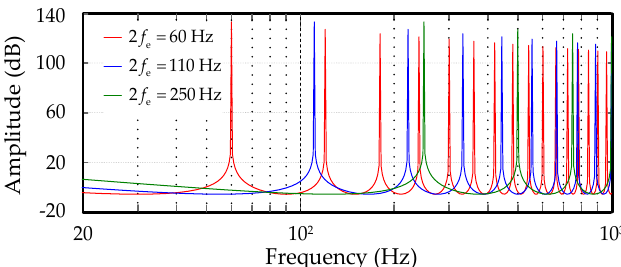
Figure 7. When Q ( z ) = 1 and k c = 1, the amplitude-frequency characteristic curves of RC under 1 k  , the amplitude-frequency characteristic curves of RC under Figure 7. When   1 Q z  and c di ff erent resonance frequencies. different resonance frequencies.